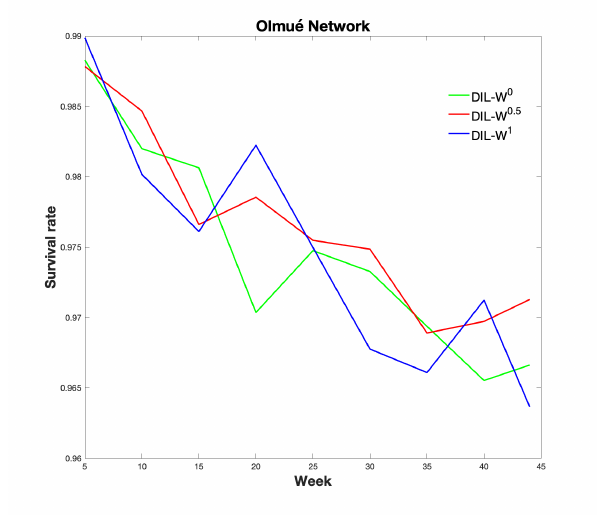
Figure 12. Survival rate of each